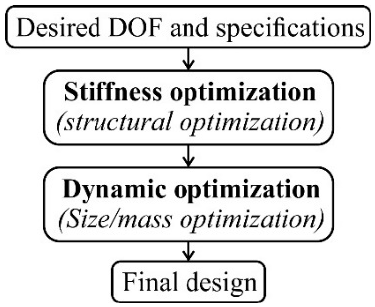
Figure 2. Optimization process of beam-based method.